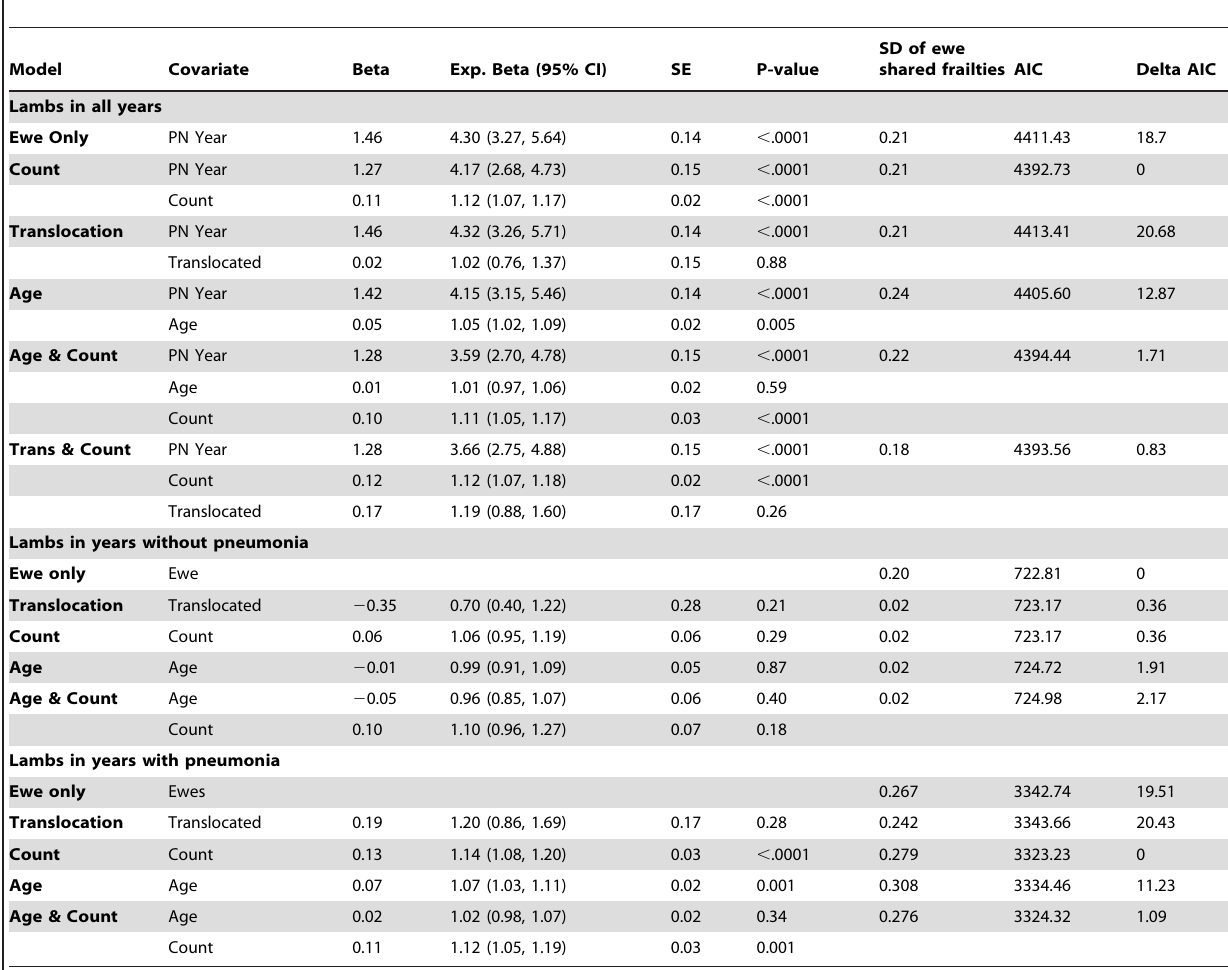
Table 6. Lambs: results from Cox proportional hazards models of lamb hazard of dying given dam (ewe) covariates in all years (pneumonia and healthy years; top), years without pneumonia (pneumonia years excluded; middle) and years with pneumonia (healthy years excluded;